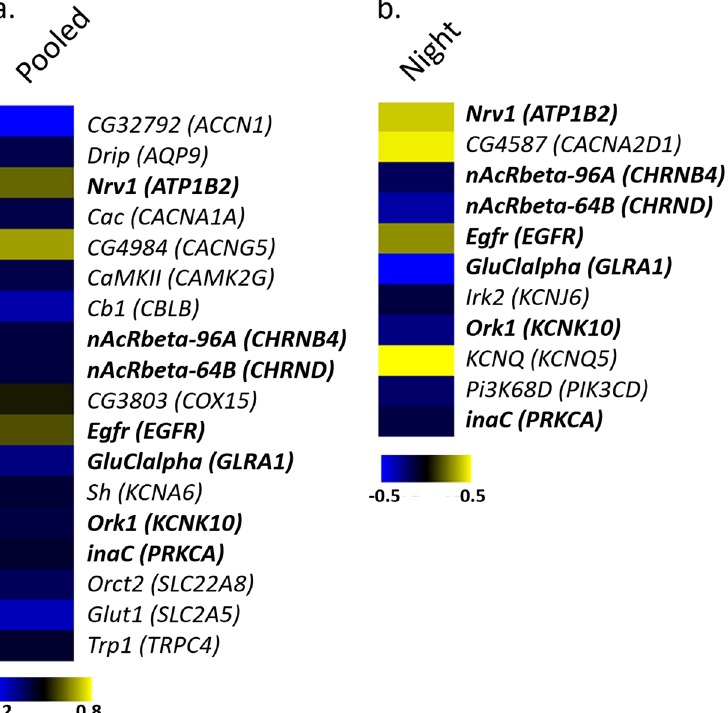
Figure 2. Differentially expressed genes in d Sur KD flies vs . controls. Heat map representing a selection of deregulated transcripts homologs to human genes (indicated in brackets) associated with sleep duration in the meta-analysis results used for the GSEA in ( a ) “Pooled” ( Drosophila pooled every 3 h of the 24 hours period) and ( b ) “Night” (3 h into the night) conditions. A color-coded scale for the normalized expression values is used as follows: yellow and blue represent high and low expression levels in d Sur KD with respect to control, respectively. The expression level of each transcript was calculated as the log2 (d Sur KD/control), and the complete lists of differentially expressed genes identified by LIMMA software are provided in the Supplementary Table